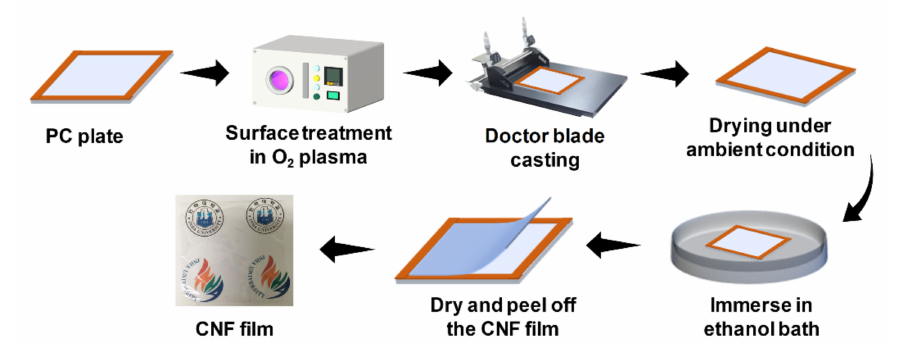
Figure 1. Schematic of CNF film fabrication